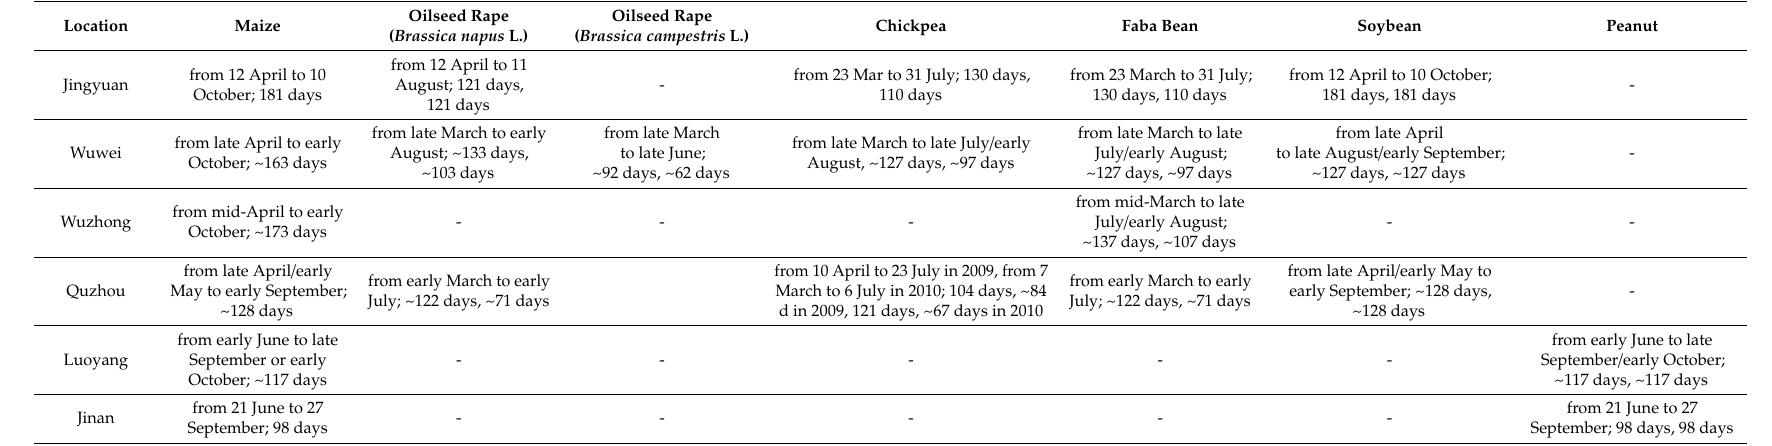
Table 5. Sowing, harvest dates, and growth days of all crops, and co-growth days of legumes and oilseed rape with maize in di ff erent experimental locations. Location Maize